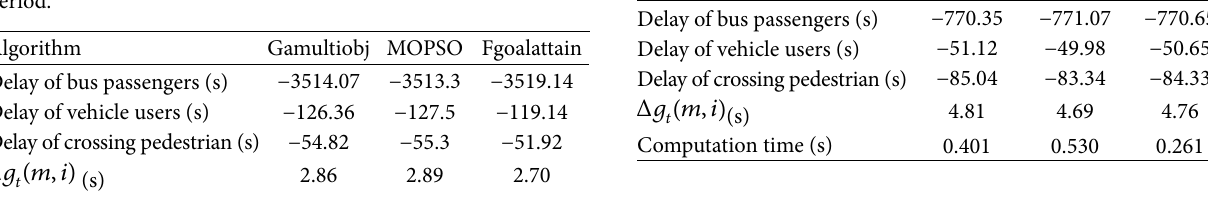
Table 9: Results of delay model in situation 3 during the nonpeak